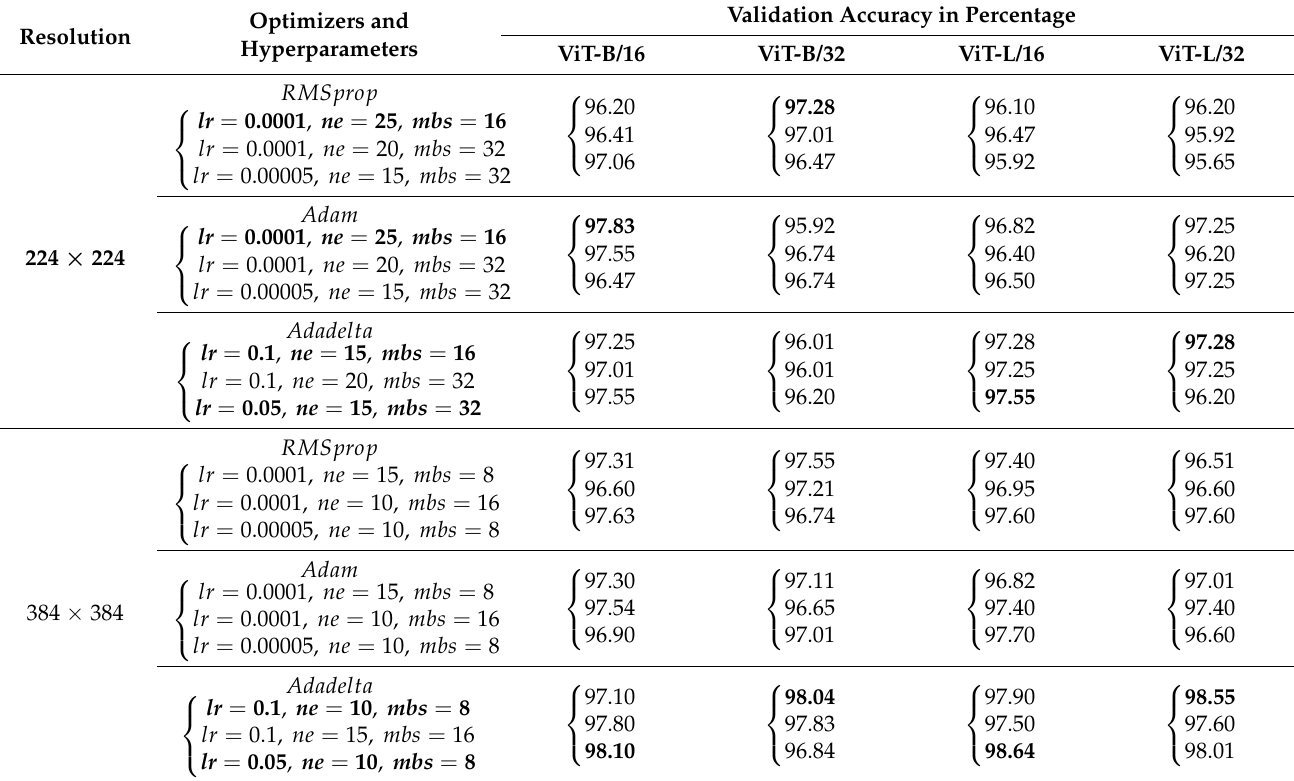
Table 2. Validation accuracy values for different optimizers and hyperparameters for ViT-B/16, ViT-B/32, ViT-L/16, and ViT-L/32 for both input image resolutions of 224 × 224 and 384 ×